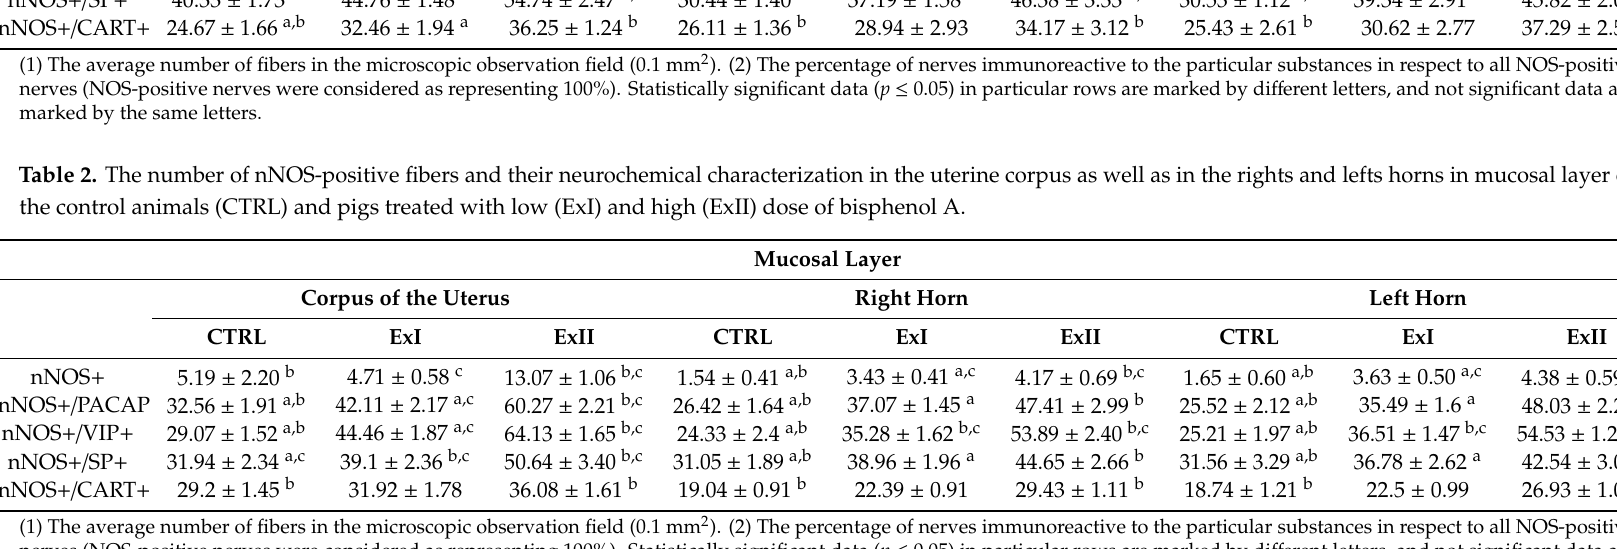
Muscular Layer Right Horn